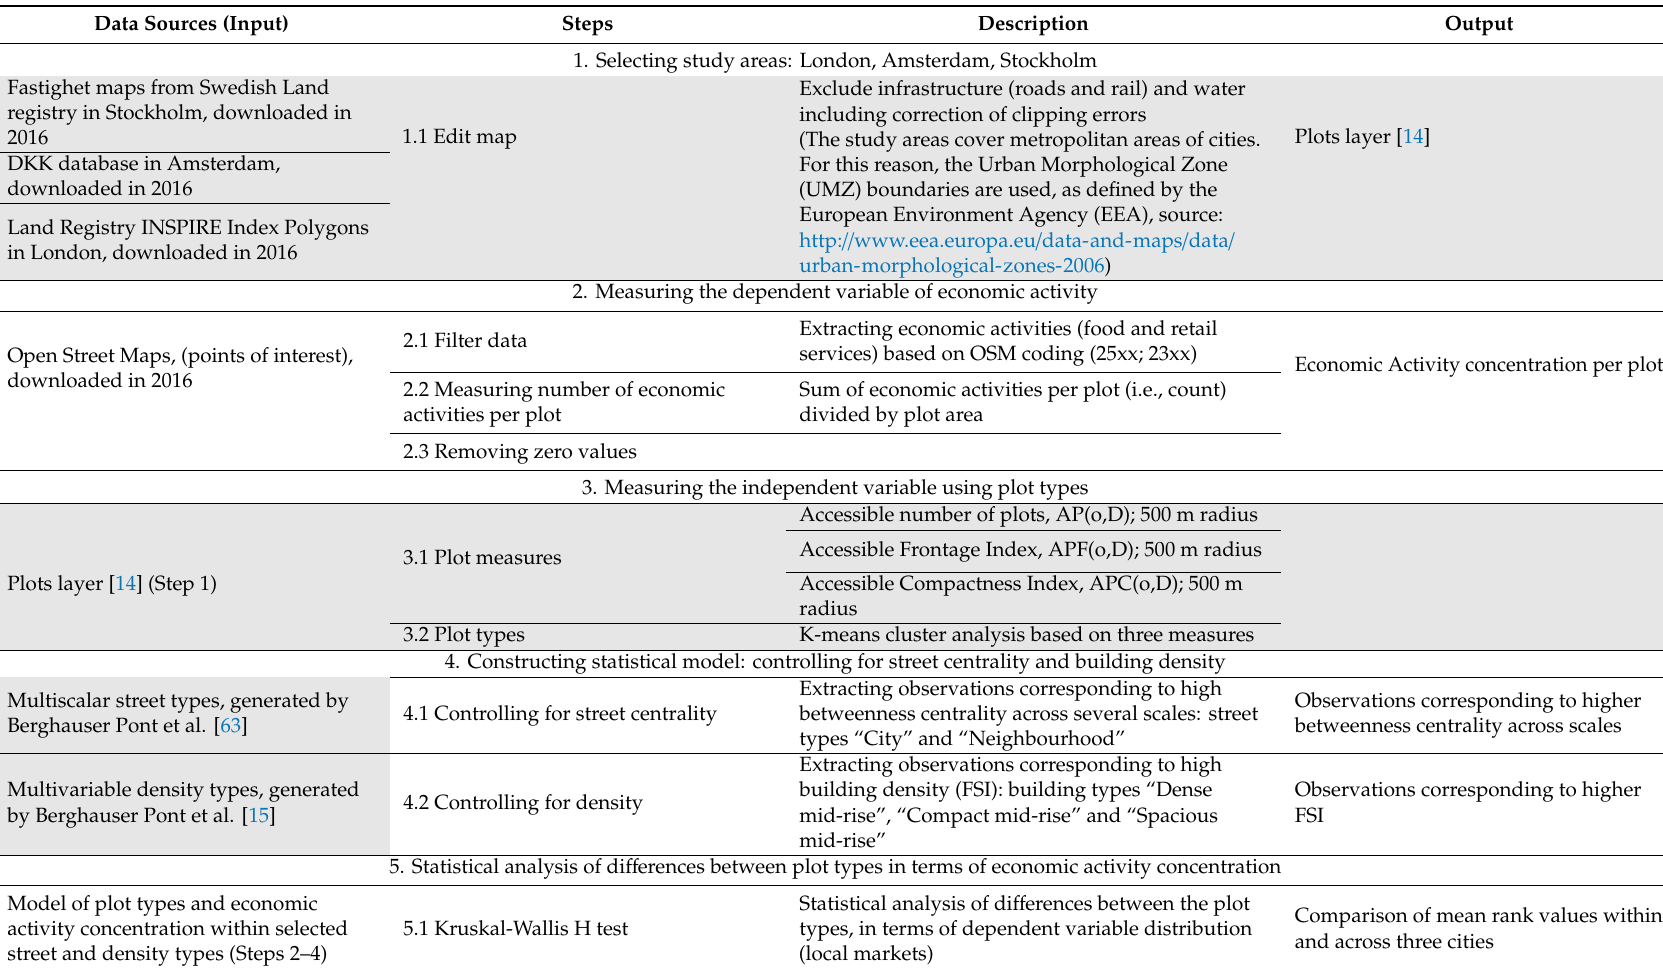
Table 1. Overview of methodological steps. Steps marked in grey were developed in earlier studies [14,15,63] and used as input for this